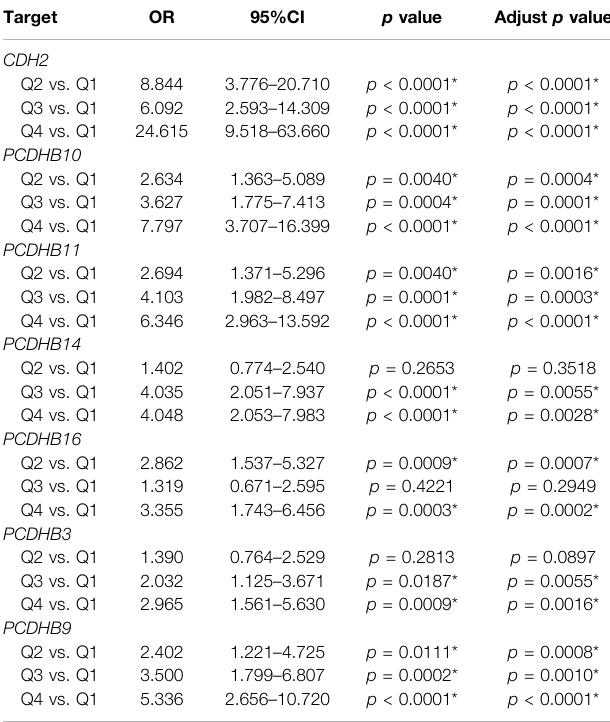
TABLE 7 | Associations between DNA methylation in 7 differentially methylated genes and risk of ischemic stroke. Target OR